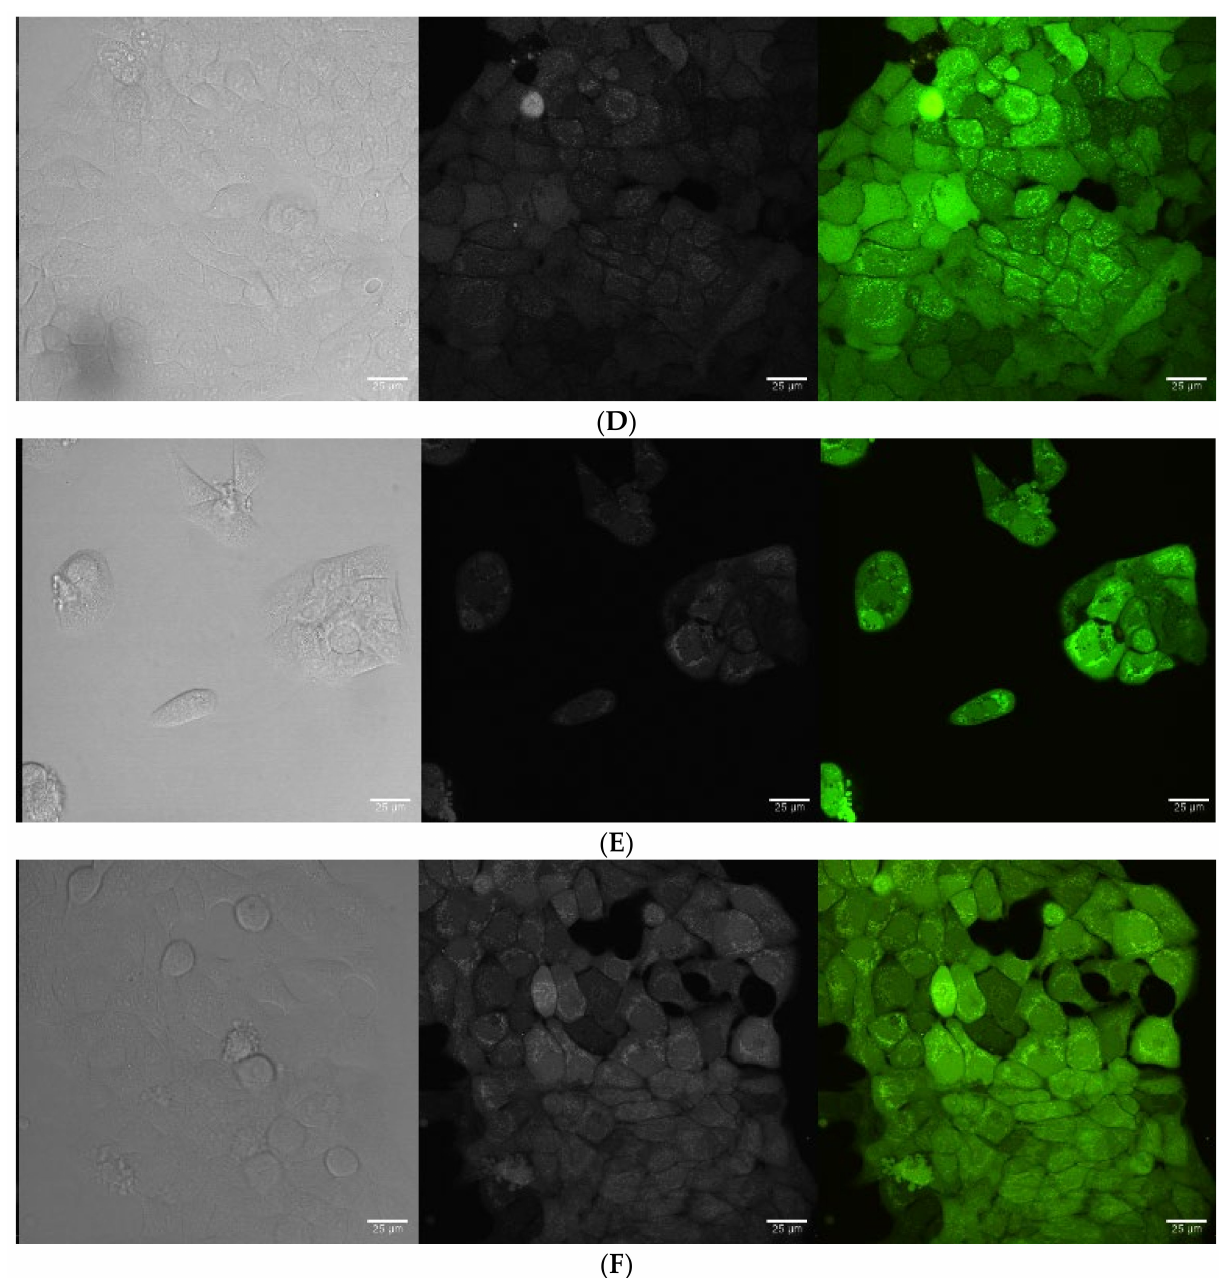
Figure 3. CSLM images of HaCaT cells dual stained with PI and FDA (red and green fluorescent): ( A ) untreated control, where cells appear to be healthy and regularly shaped polygonal cells with high confluency; ( B , D , F ) cells treated with Aizoon canariense , Maerua crassifolia , and Tribulus macropterus , appearing to be healthy-shaped and homogeneously distributed; ( E ) cells treated with Rhazya stricta —although it appears to be healthy cells, confluency was low (around 20%); ( C ) cells treated with Citrullus colocynthis , showing extreme morphological changes with very low